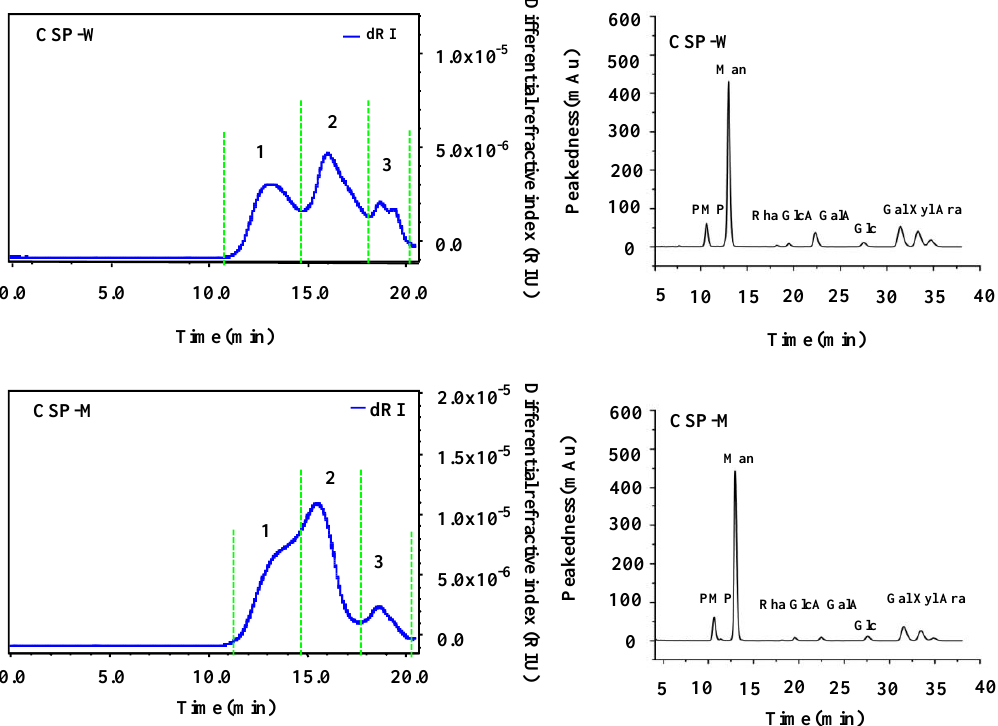
Figure 3. High performance size exclusion chromatograms (left) and high performance liquid chromatography profiles (right) of CSP-W and CSP-M. CSP-W , Cassia seed polysaccharides extracted by hot water extraction; CSP-M , Cassia seed polysaccharides extracted by microwave-assisted extraction; PMP , 1-phenyl-3-methyl-5-pyrazolone; Man , mannose; Rha , rhamnose; GlcA , glucuronic acid; GalA , galacturonic acid; Glc , glucose; Gal , galactose; Xyl , xylose; Ara , arabinose. Table 4. Molecular weights ( M w ), polydispersities ( M w / M n ), intrinsic viscosities ([ η ]), and constituent monosaccharides of CSP-W and